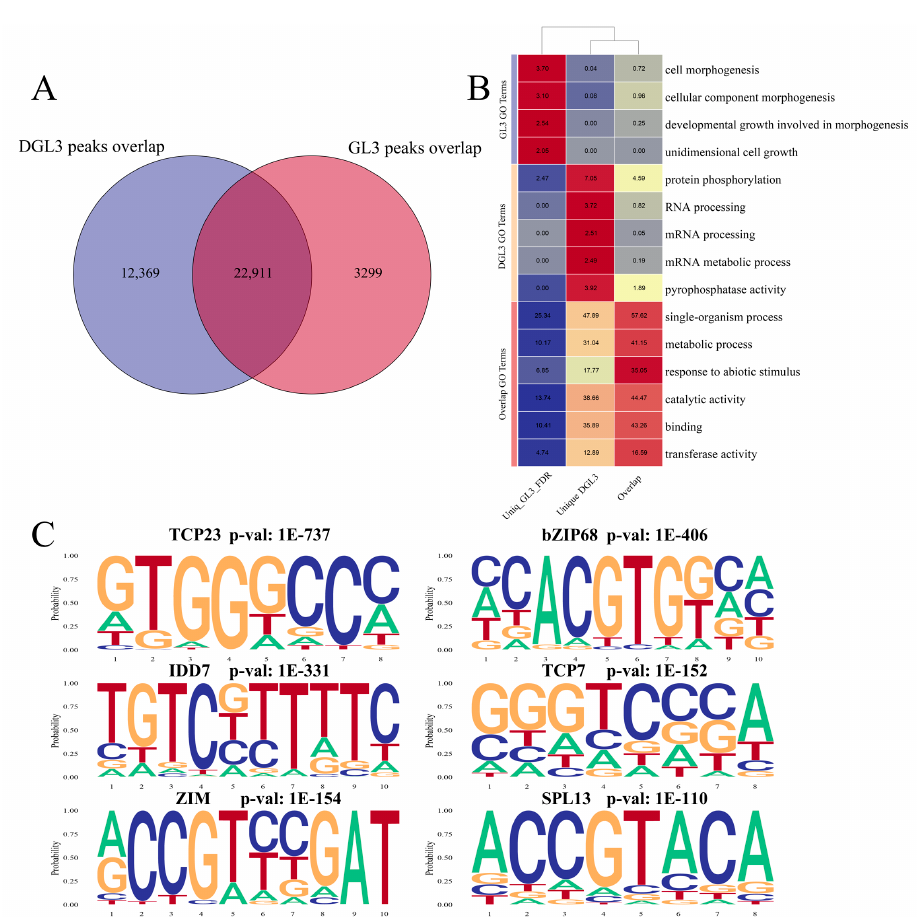
Figure 3. Functional enrichment of ATAC-seq results during the drought treatment. ( A ) The overlap of ATAC signals of the control and drought treatment. ( B ) The GO enrichment of ATAC signal-related genes of unique GL3, unique DGL3, and Overlap. Heatmap tagged with the number − log 10 (FDR). Blue to yellow and then to red, representing a gradual increase in significance. ( C ) The motif analysis of overlap peaks in control and drought treatment.